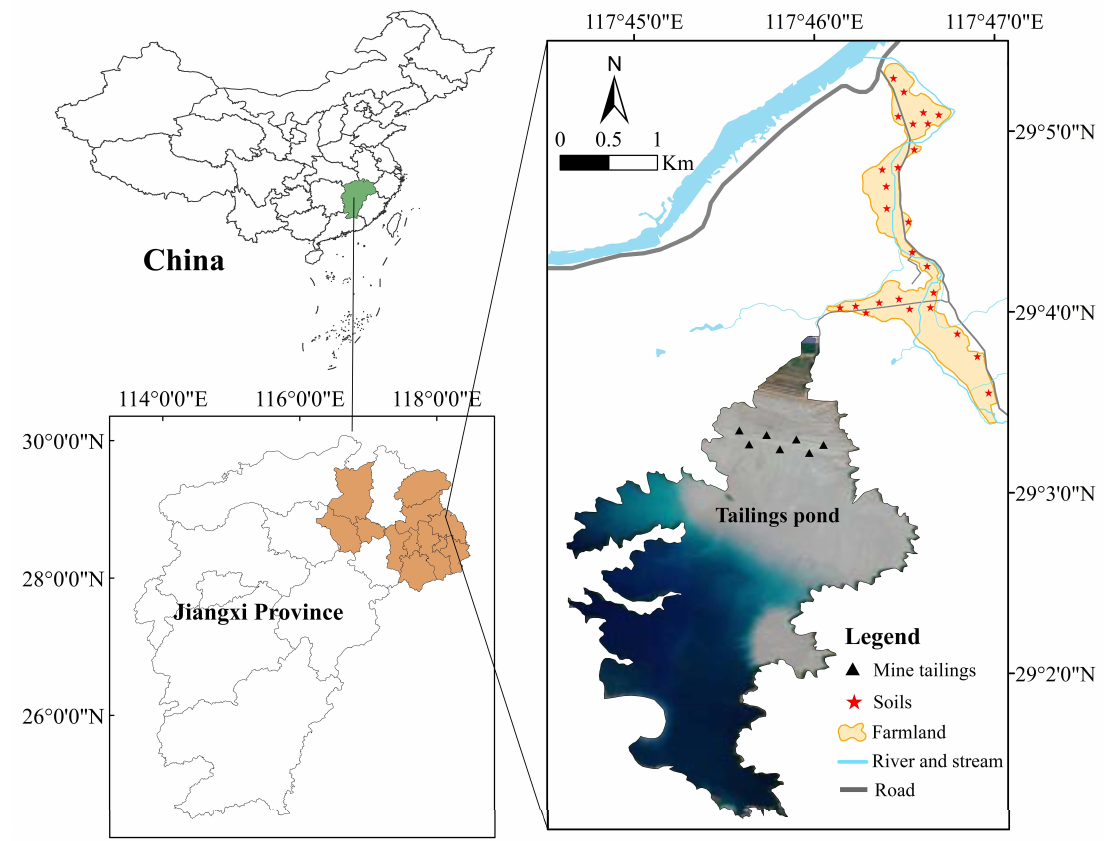
Figure 1. Study area and sampling sites.